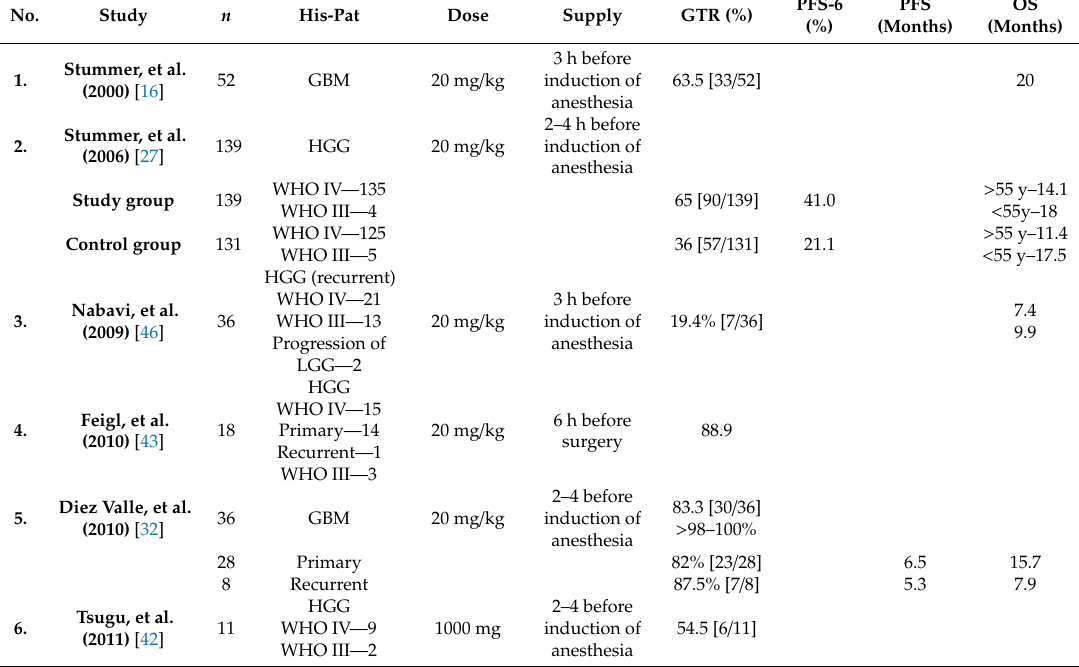
Table 1. Gross total resection rate using intraoperative navigation with 5-aminolevulinic